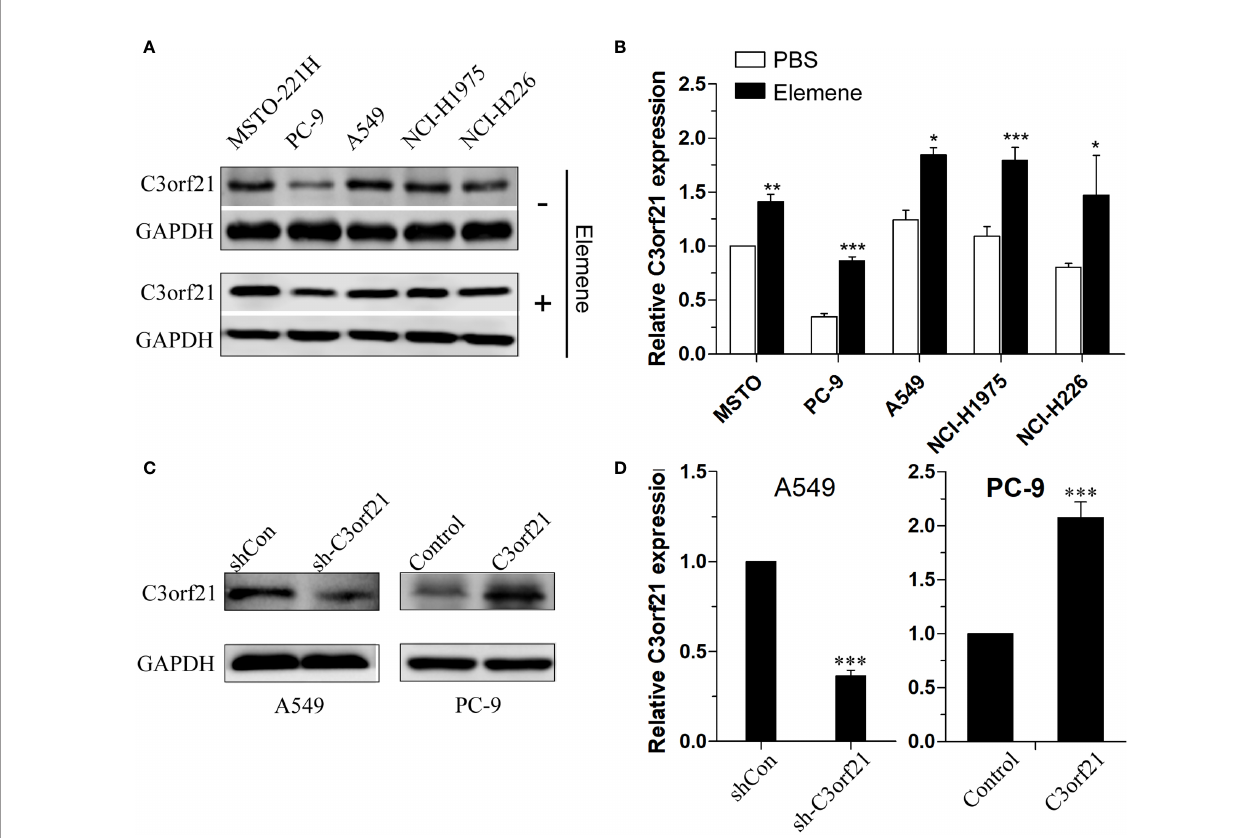
FIGURE 4 | C3orf21 expression in NSCLC cells. (A) Western blot analysis of the relative levels of C3orf21 expression in the indicated NSCLC cells. (B) Beta-elemene enhances C3orf21 expression in NSCLC cells. (C, D) Generation of C3orf21 stable silencing A549 cells and C3orf21 stable over-expressing PC-9 cells. Data are representative images or expressed as the mean ± SD of each group from three biological experiments. *P < 0.05, **P < 0.01 and ***P < 0.001 vs. the